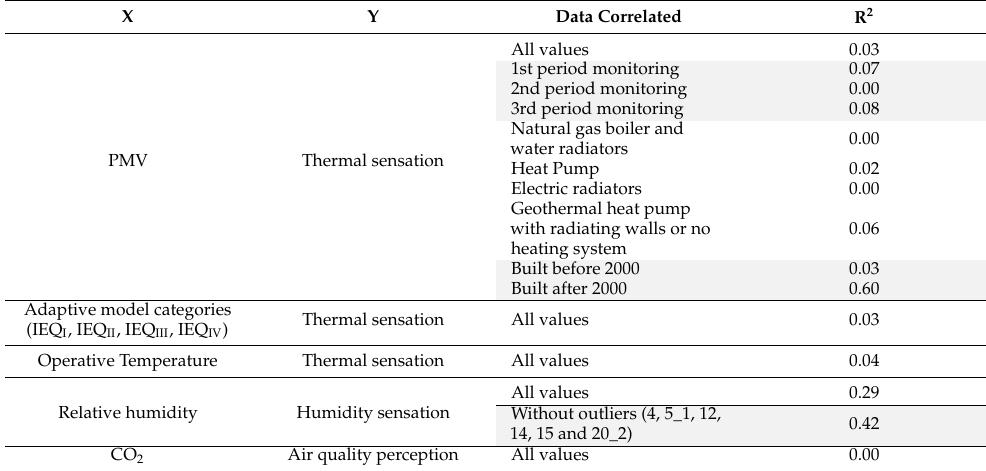
Table 7. Linear fitting results for direct votes in surveys (Y) and point-in-time measurements (X). X Y Data